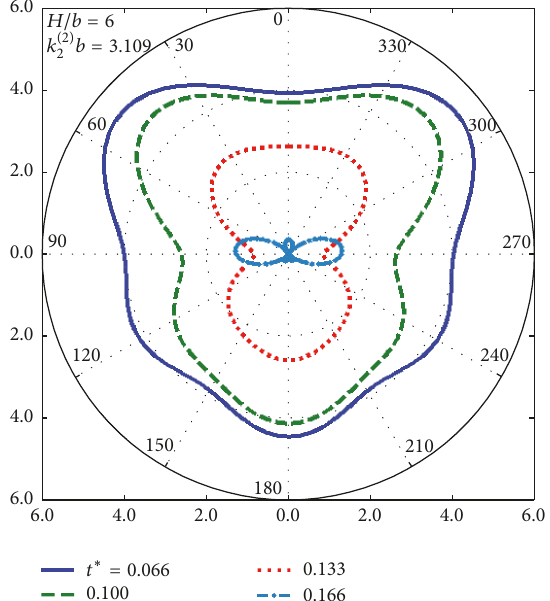
Figure 17: Tangential stress (𝜎 ∗ 𝜃𝜃 ) versus polar angle at 𝑟 = 𝑏 for different thicknesses (𝑡 ∗ ) for a tunnel in soft